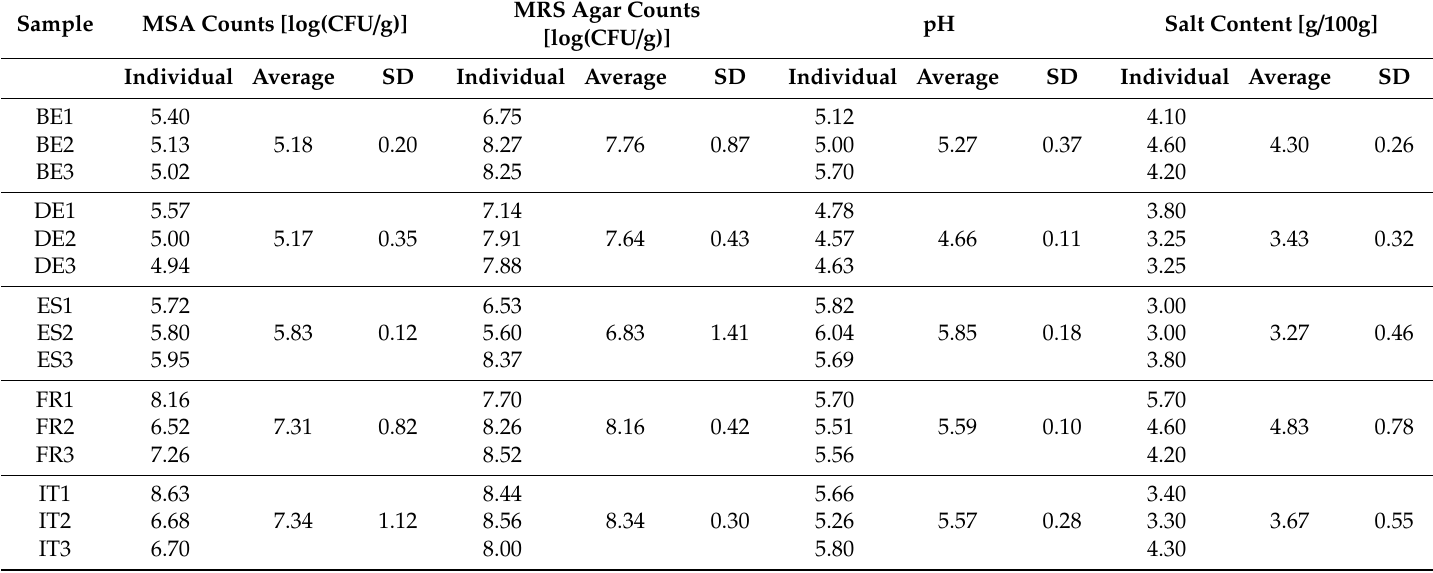
Table 2. Individual and average bacterial counts, pH, and salt content with standard deviation (SD) of selected commercial fermented meat products originating from BE (Belgium), DE (Germany), ES (Spain), FR (France), and IT (Italy). MSA, mannitol-salt-agar (representing presumptive staphylococcal species); MRS, de Man–Rogosa–Sharpe (representing presumptive lactic acid bacterial